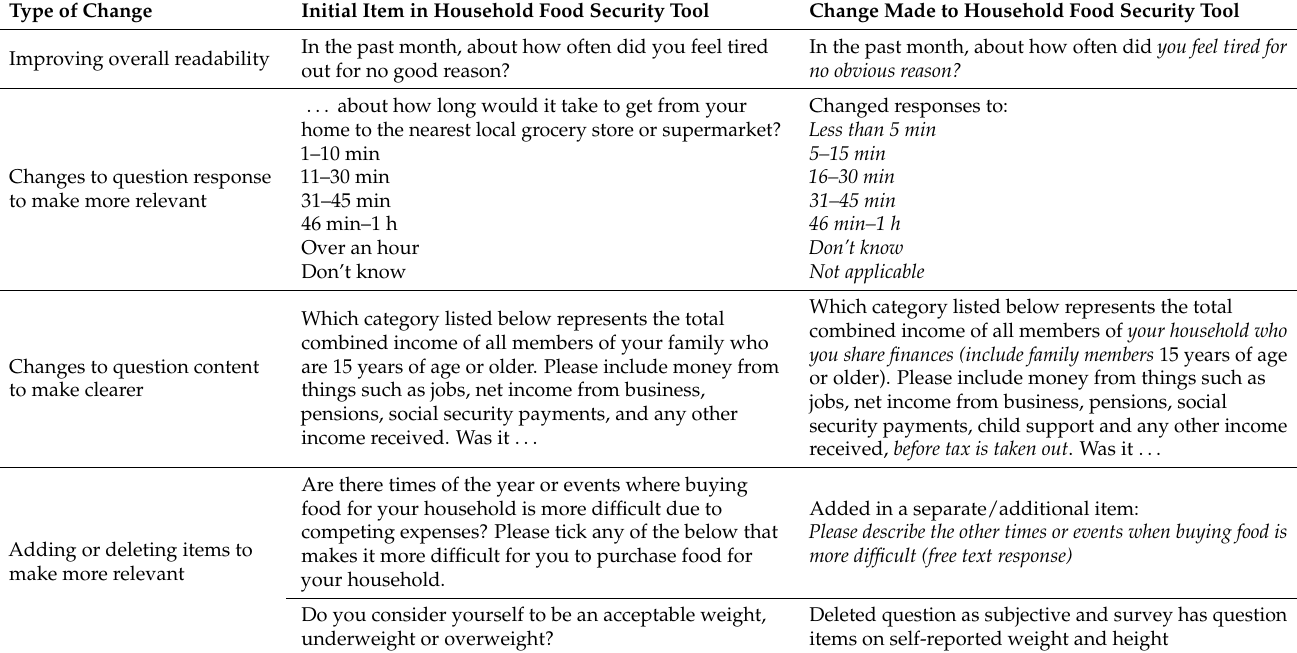
Table 3. Examples of changes made to the comprehensive household food security tool resulting from cognitive